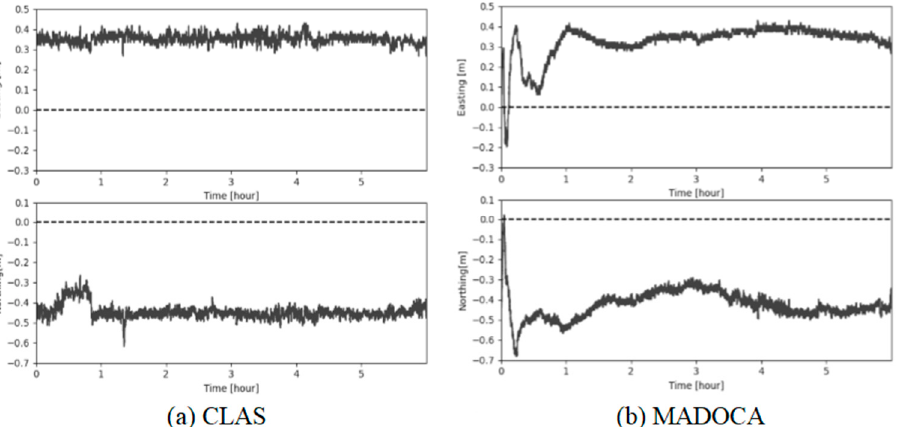
Figure 7. Logged positioning data for six hours from the static positioning experiment ( a ) CLAS, ( b ) MADOCA.